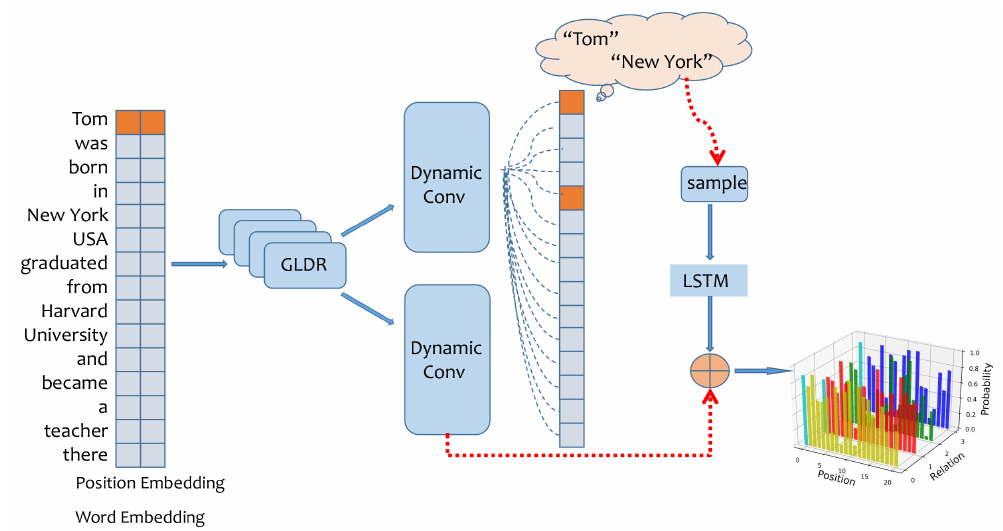
Figure 5. The overall architecture of our model. Our algorithm contains two stages, E1 prediction and multi-turn E2 prediction, and the relations are predicted together with E2 in the second stage.